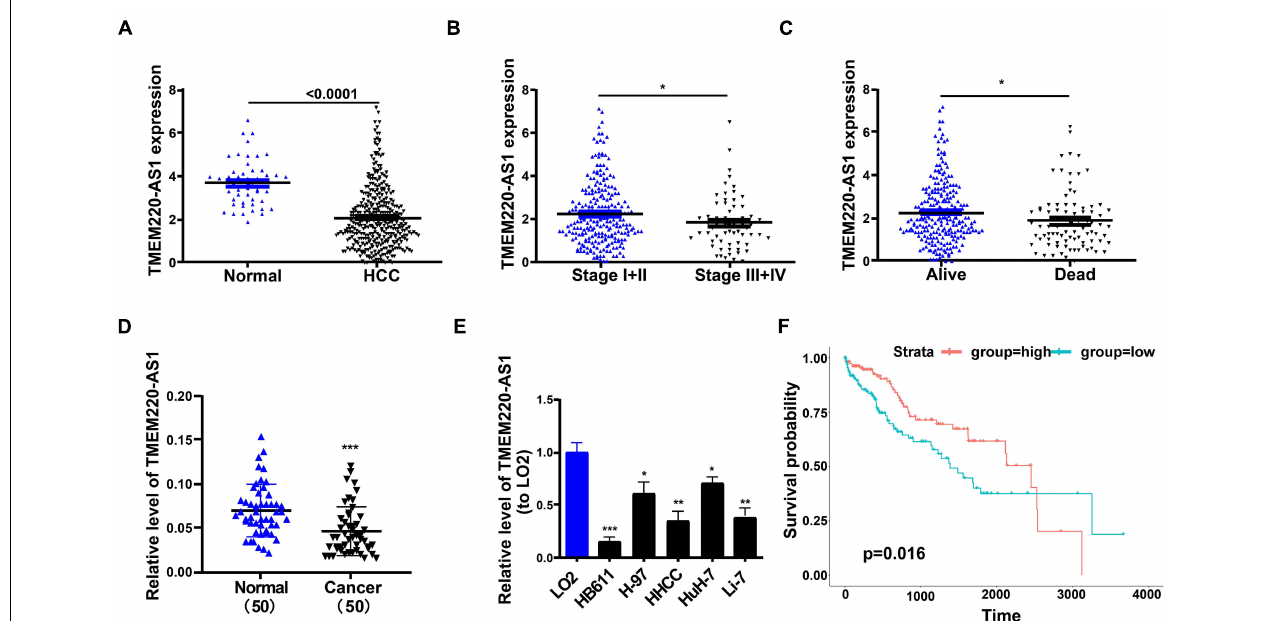
FIGURE 1 | Low level of TMEM220-AS1 in HCC tissues and cell lines. (A) TME M220-AS1 expression in HCC samples and normal samples, from TCGA database. (B) TMEM220-AS1 expression in stage I + II and stage III + IV, from TCGA database. (C) TMEM220-AS1 expression in alive samples and dead samples, from TCGA database. (D) TMEM220-AS1 expression in HCC tissues and paired adjacent normal tissues was analyzed by qRT-PCR. (E) TMEM220-AS1 expression in HCC cell lines and LO2 cell line was analyzed by qRT-PCR. (F) Kaplan-Meier curves of overall survival (OS) from TCGA database. Data represent the mean ± SD; * P < 0.05, ** P < 0.01, *** P <